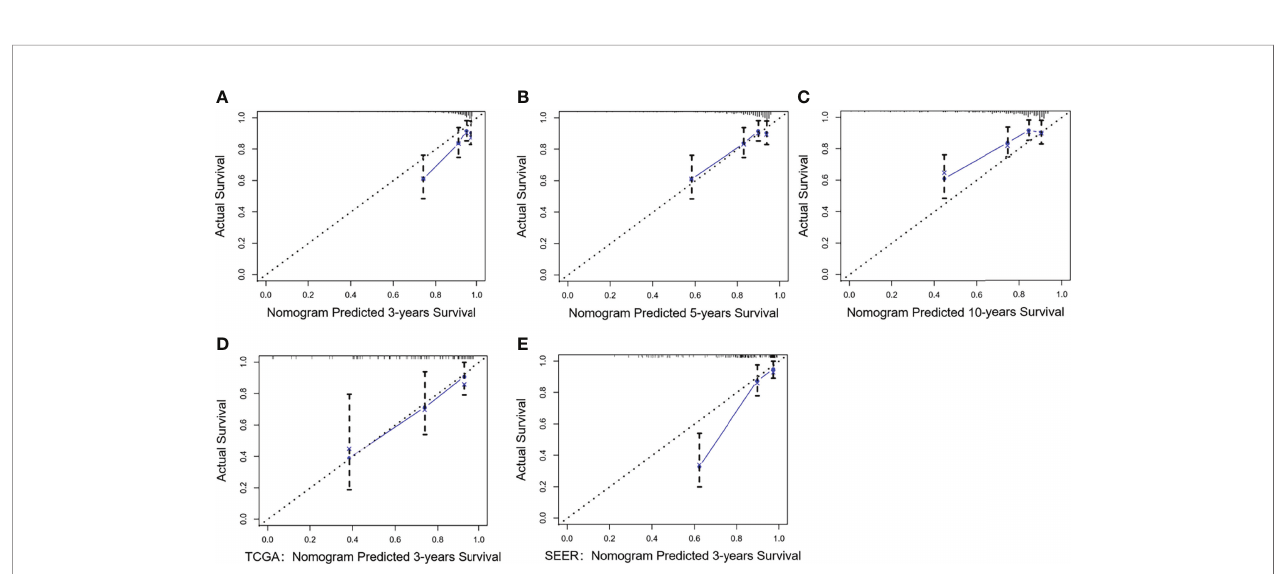
FIGURE 5 | Calibration curves of Model II for the training and validation cohorts. Nomogram-predicted OS is plotted on the x-axis; actual OS is plotted on the y-axis. A plot along the 45° line indicates a perfect calibration model in which the predicted OS is identical to the actual outcomes. (A – C) The 3-, 5-, and 10-year calibration curves for the training cohort; (D) The 3-year calibration curve for the TCGA validation cohort; (E) The 3-year calibration curve for the SEER validation